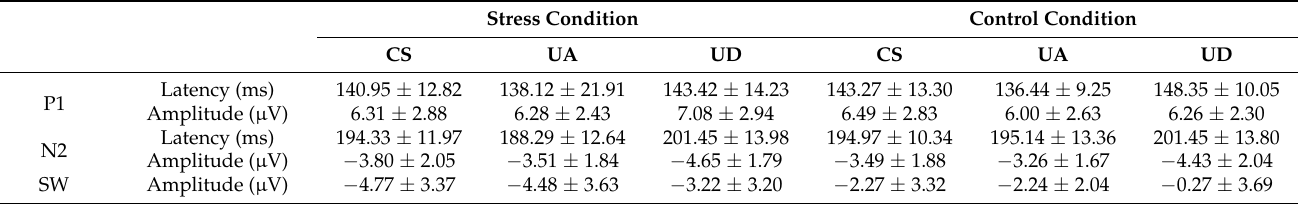
Table 1. Mean and SD for latency and amplitude of P1, N2. Mean and SD for the mean amplitude of